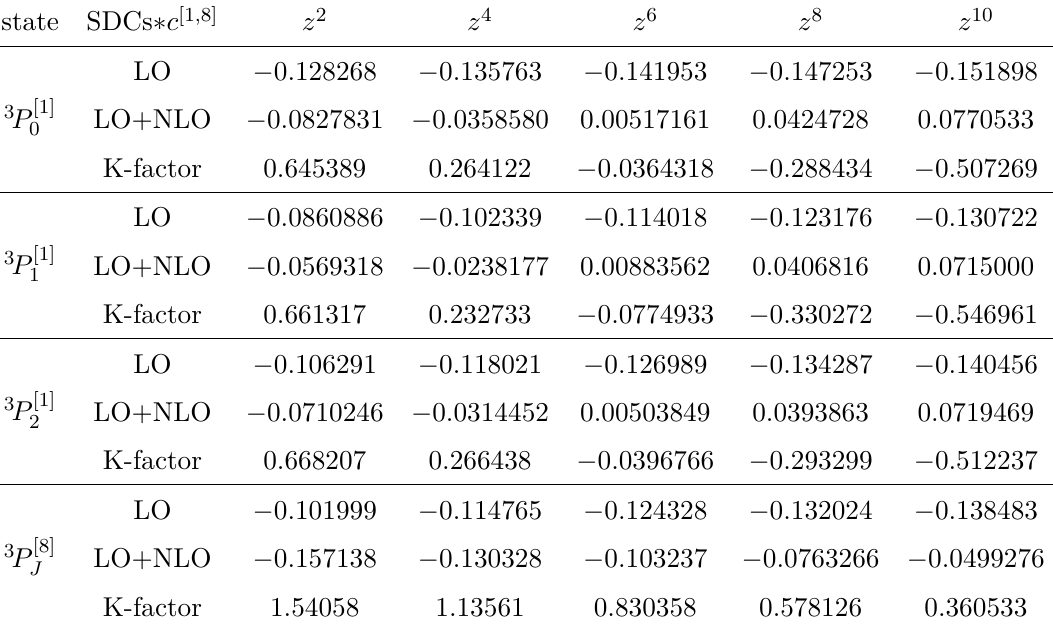
Table 4 . Moments and K-factors of b ¯ b